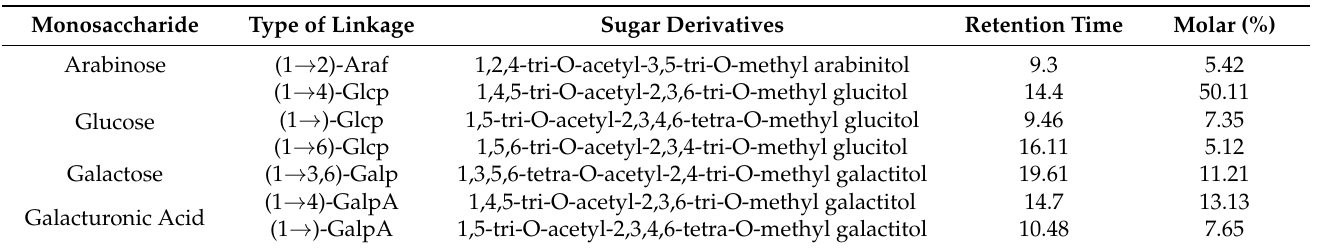
Table 2. Deduced Glycosidic Linkage Type and Composition of PPL-1. Determined via Methylation and GC–MS